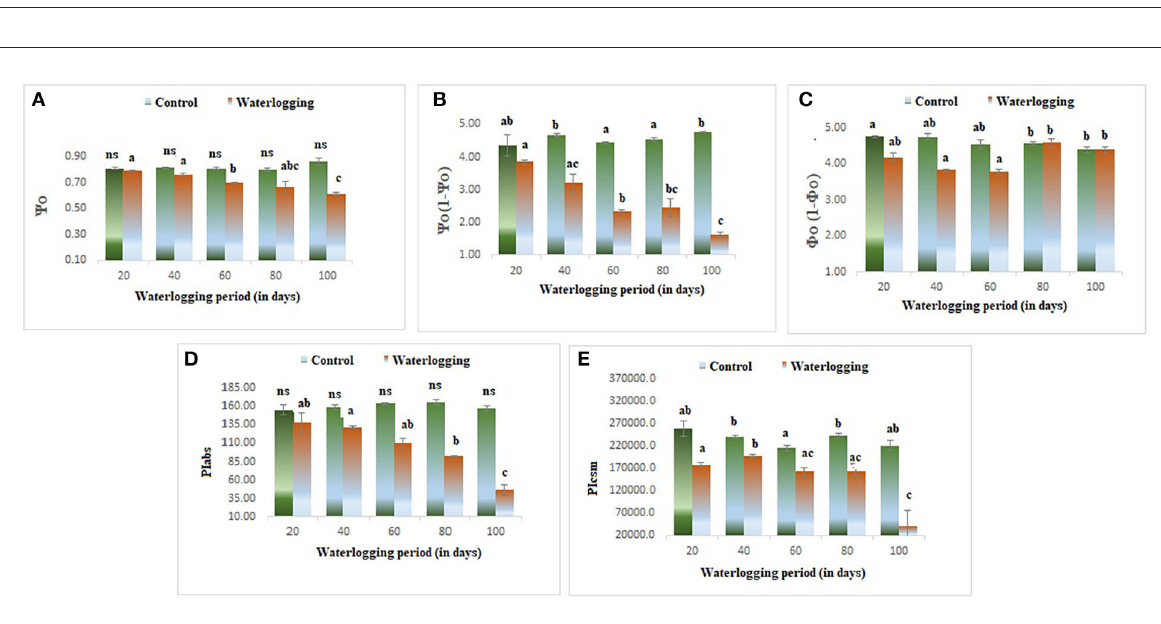
correlation under waterlogging. Data indicates that Fo, Fi, ABS/RC, TR/RC, DI/RC, ABS/CSm, TR/CSm, and DI/CSm are positively correlated to each other whereas Fm, Fj, Vj, Fv/Fo, ET/RC, ET/CSm, Piabs, and Picsm are positively correlated to each